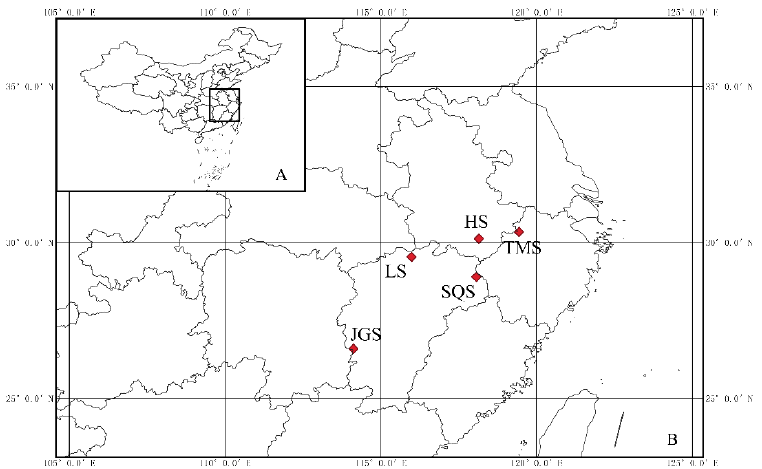
Figure 1. ( A ) The core distribution of P. massoniana and P. hwangshanensis in Jiangxi, Anhui, and Zhejiang, China. ( B ) The population locations of the two pine species. The codes and corresponding populations are SQS (Mt. Sanqingshan, Jiangxi), LS (Mt. Lushan, Jiangxi), JGS (Mt. Jinggangshan, Jiangxi), HS (Mt. Huangshan, Anhui), and TMS (Mt. Tianmushan, Zhejiang). The geographic locations for each population are shown in Table 1. According to the elevation gradients of the two pine species, two or three sites (i.e., elevations) were selected for each population of the two pine species. A 20 × 50 m quadrat was set up for each